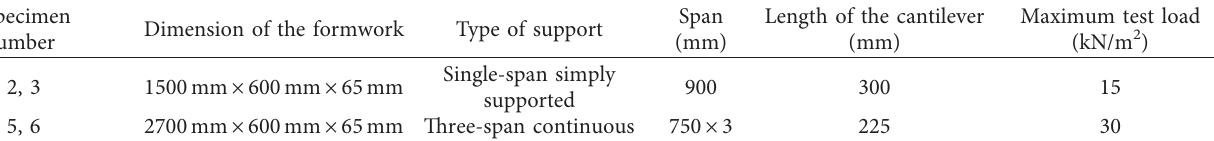
Table 2: Loading program of the